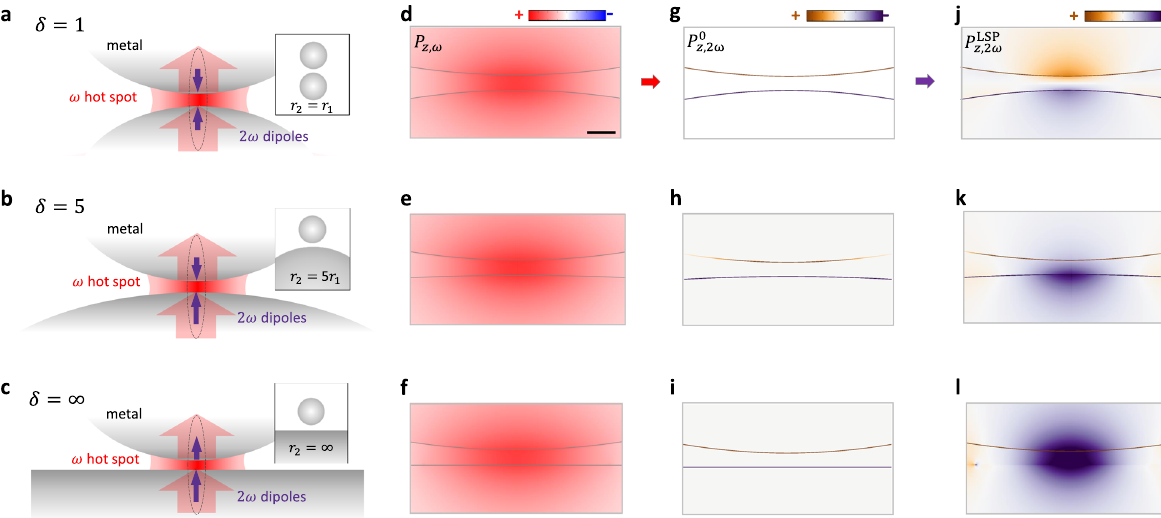
Fig. 2 Analysis of the SH origin in gold nanodimers with different symmetry conditions. a – c Schematics of the SH origin in the nanodimers with varying = r degrees of structural asymmetry de fi ned by the particle size ratio, δ ¼ r . Red thick arrows indicate the dipolar response to the driving fi eld oriented 2 1 along the nanogap, E ? , with the ω -hot-spot forming between the nanoparticles for boosting the nonlinear source. Purple arrows represent the induced 2 ω dipoles responsible for the far- fi eld SH radiation. d – f Simulated near- fi eld polarization distributions, P z ; ω , at the fundamental wavelength of 850 nm for the structures in ( a ) – ( c ) with r 1 ¼ 100 nm and a gap g ¼ 1 nm. Scale bar in ( d ) is 2 nm. g – i Calculated near- fi eld polarization distributions, P 0 , at the SH z ; 2 ω wavelength induced by the respective fundamental fi elds (Eq. (1)), which are signi fi cant only at the interface of the centrosymmetric metal. j – l SH polarization distributions resulting from the non-resonant plasmonic coupling of the surface nonlinear sources in ( g ) – ( i ) to the nanodimers. Note that spatial nonlocality and quantum tunneling are not considered in the electrodynamic calculations since they only begin to emerge in narrower metal nanogaps ( < 1 nm) 47,48 .